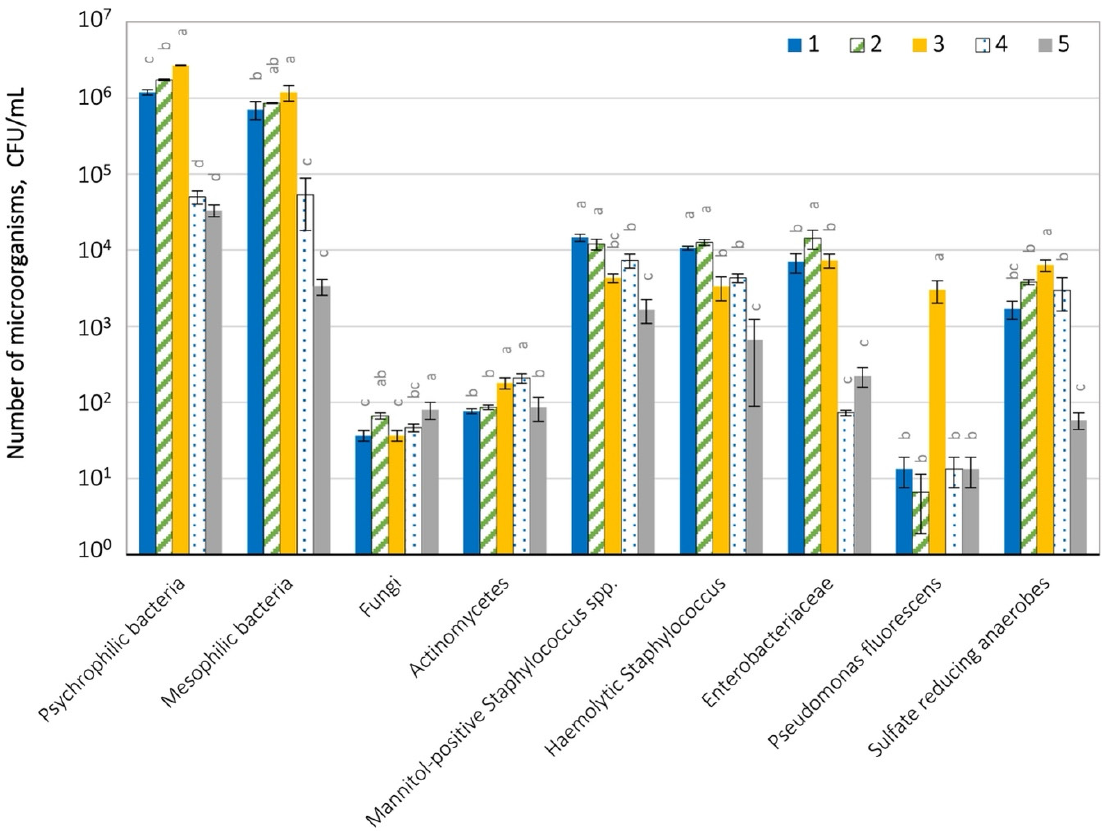
Figure 5. Microbiological contamination of leachate in the tested landfill; 1–5 leachate sample numbers; statistically different samples within the same microorganism group were marked with different letters (Tukey’s test at p = 0.05).